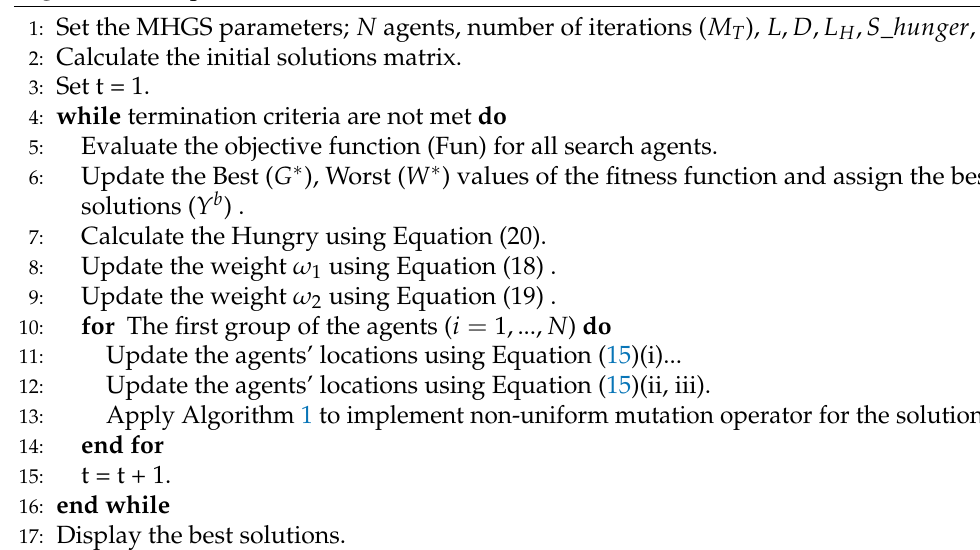
Algorithm 2 Steps of MHGS.